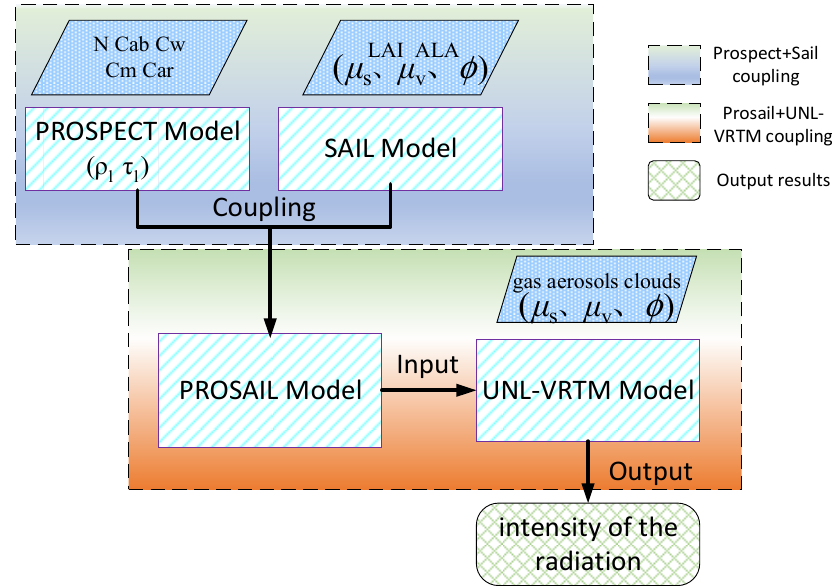
Figure 1. Diagram of the coupling model (where µ s and µ v are cosine of solar zenith angle and cosine of view zenith angle, respectively, and 𝜙 is relative azimuth angle.)